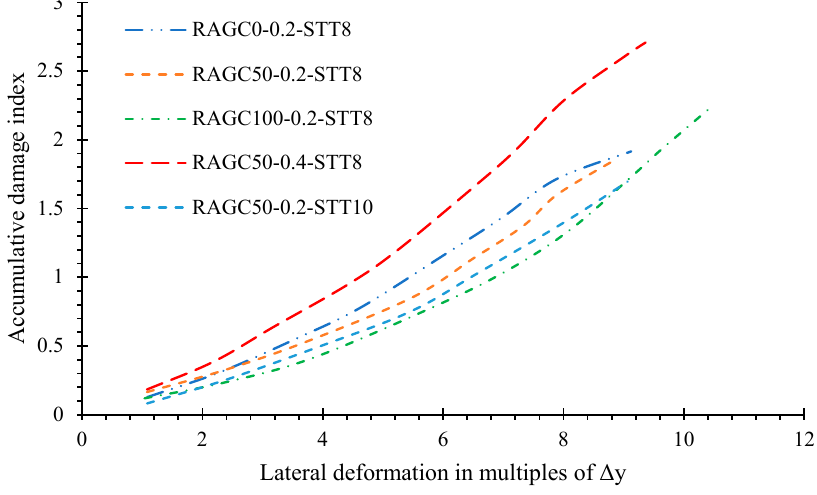
Figure 11. Accumulative damage index.